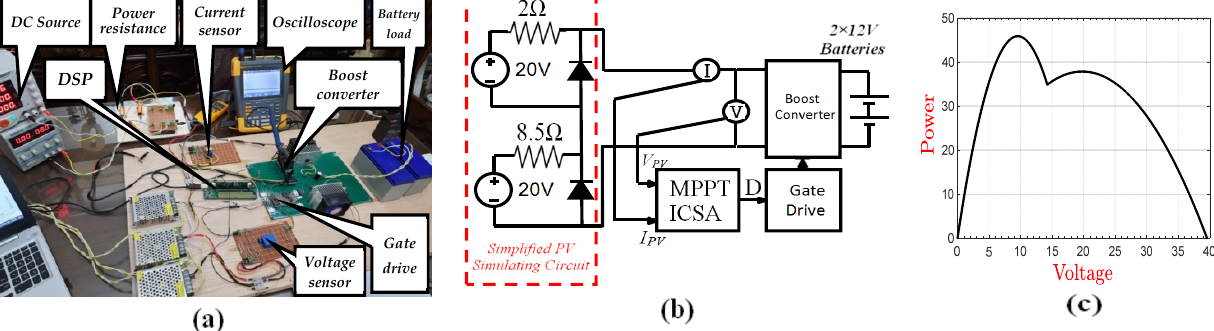
Figure 12. The experimental construction. ( a ) The experimental photography. ( b ) The schematic diagram. ( c ) The P-V curve of simulated PV circuit.